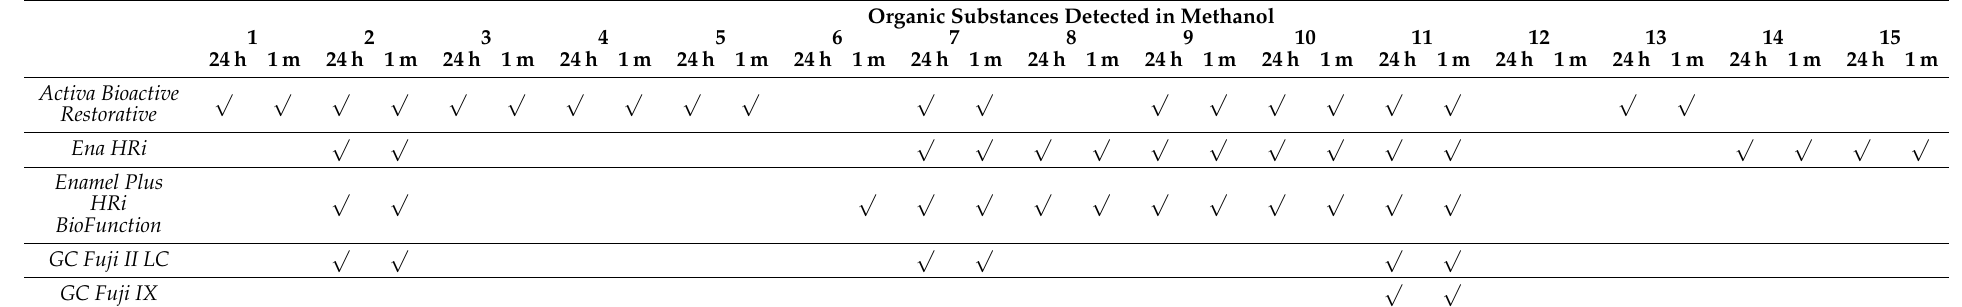
Table 3. Analytes detected in methanol of the five investigated materials for both observation periods (24 h and 1 month). The numbers correspond to the eluates reported in Table